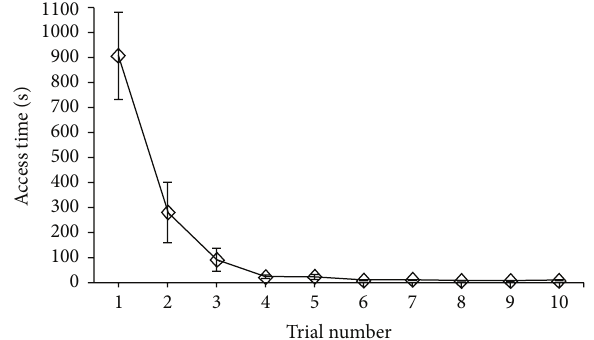
Figure 3: The learning curve (time/sec) ( ± SE) taken to access and forage on syrup for 10 initially naive workers of Bombus impatiens which were allowed to forage freely, but only one at a time, at artificial flowers with and without dead bees present. After the bees had demonstrated their ability to forage at the flowers with dead bees present (i.e., after 3 trails), those flowers were replaced with cleaned ones without dead bees present. The activities of the foragers were recorded for a further 7 visits. H 0 showing that the durations for successful foraging are independent of experience is rejected ( 𝐹 9,9 = 19.7 ; 𝑃 < 0.001 ).